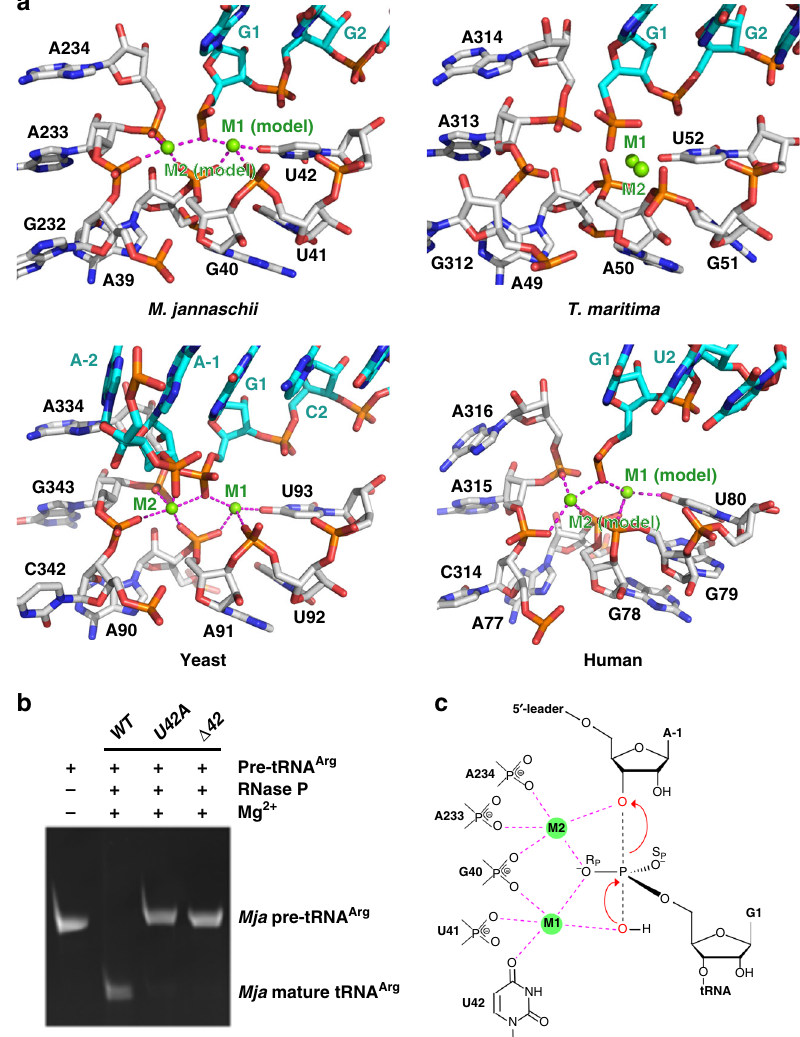
Fig. 7 The catalytic center of Mja RNase P. a Close-up views of the catalytic centers of Mja RNase P (top left), T. maritima RNase P (top right, PDB: 3Q1Q), yeast RNase P (bottom left, PDB: 6AH3), and human RNase P (bottom right, PDB: 6AHU). Two catalytic Mg 2 + ions (M1 and M2) in the active site of Mja RNase P and human RNase P shown in green spheres were modeled based on the yeast RNase P-tRNA complex structure. RPR and tRNA are showed in stick representation and colored in silver and cyan, respectively. The coordination of the two Mg 2 + ions is denoted by magenta dashed lines. b In vitro pre- tRNA processing assay of the Mja RNase P holoenzyme reconstituted with WT, U42A and Δ U42 RPR, respectively. c Proposed reaction mechanism for 5 ′ - leader cleavage of pre-tRNA by Mja RNase P. The reactive oxygens are colored in red, the pre-tRNA scissile phosphate is depicted in a transition state, and the interactions between catalytically important nucleotides and reactive oxygens mediated by Mg 2 + ions (M1 and M2) are shown as magenta dashed